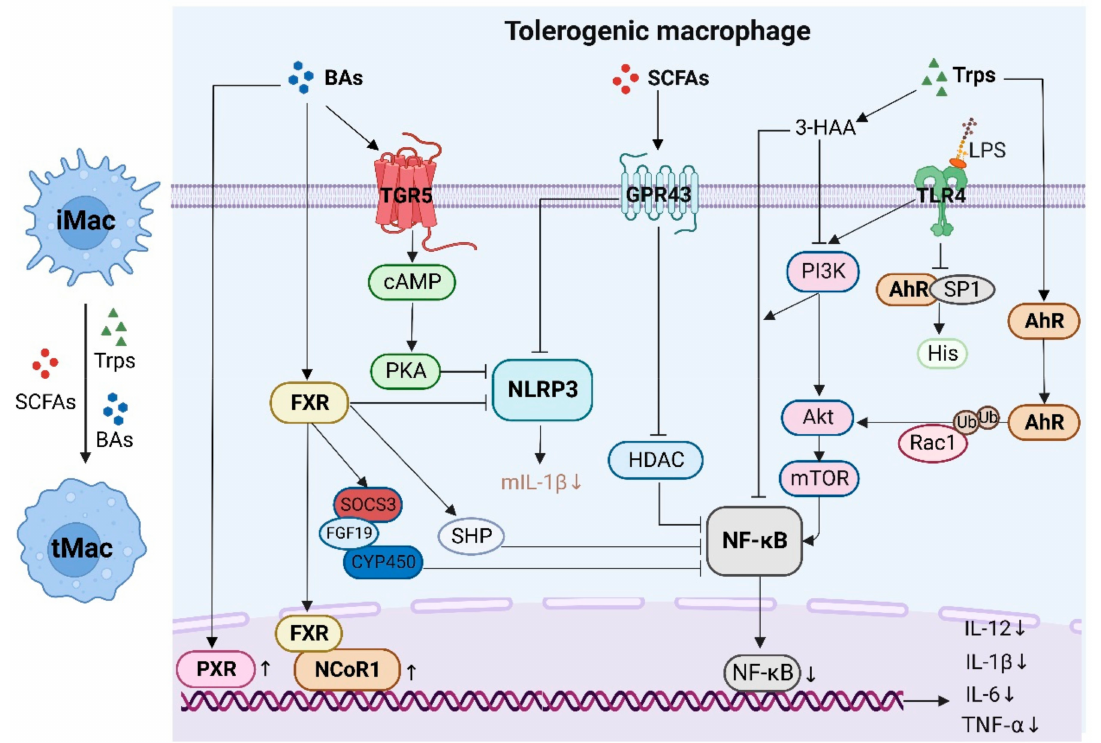
Figure 3. Gut-microbiota-derived metabolites promote the differentiation and function of tolerogenic macrophages through the receptors expressed in the macrophages such as short-chain fatty acids (SCFAs) through membrane receptors such as GPR43, tryptophan metabolites (Trps) through the AhR nuclear receptor and bile acid metabolites (BAs) through the TGR5 membrane receptor and/or FXR nuclear receptor. iMac, inflammatory macrophages; tMacs, tolerogenic macrophages; TGR5, Takeda G protein-coupled receptor 5; FXR, farnesoid X receptor; PXR, pregnane X receptor; NCOR1, nuclear receptor corepressor 1; cAMP, adenosine monophosphate; PKA, protein kinase A; SOCS3, suppressor of cytokine signaling 3; CYP450, cytochrome P450; FGF19, fibroblast growth factor 19; NLRP3, NOD-like receptor thermal protein domain associated protein 3; GPR43, G-protein coupled receptor 43; HDAC, histone deacetylase; NF- κ B, nuclear factor-kappa B; PI3K, phosphatidylinositol 3 kinase; Akt, protein kinase B; mTOR, mammalian target of rapamycin; TLR4, Toll-like receptor 4; 3-HAA, 3-hydroxyanthranilic acid; SP1, specificity protein 1; His, histamine; AhR, aryl hydrocarbon receptor; Rac1, ras-related C3 botulinum toxin substrate 1; mIL-1 β , mature interleukin -1 β ; TNF α , tumor necrosis factor α